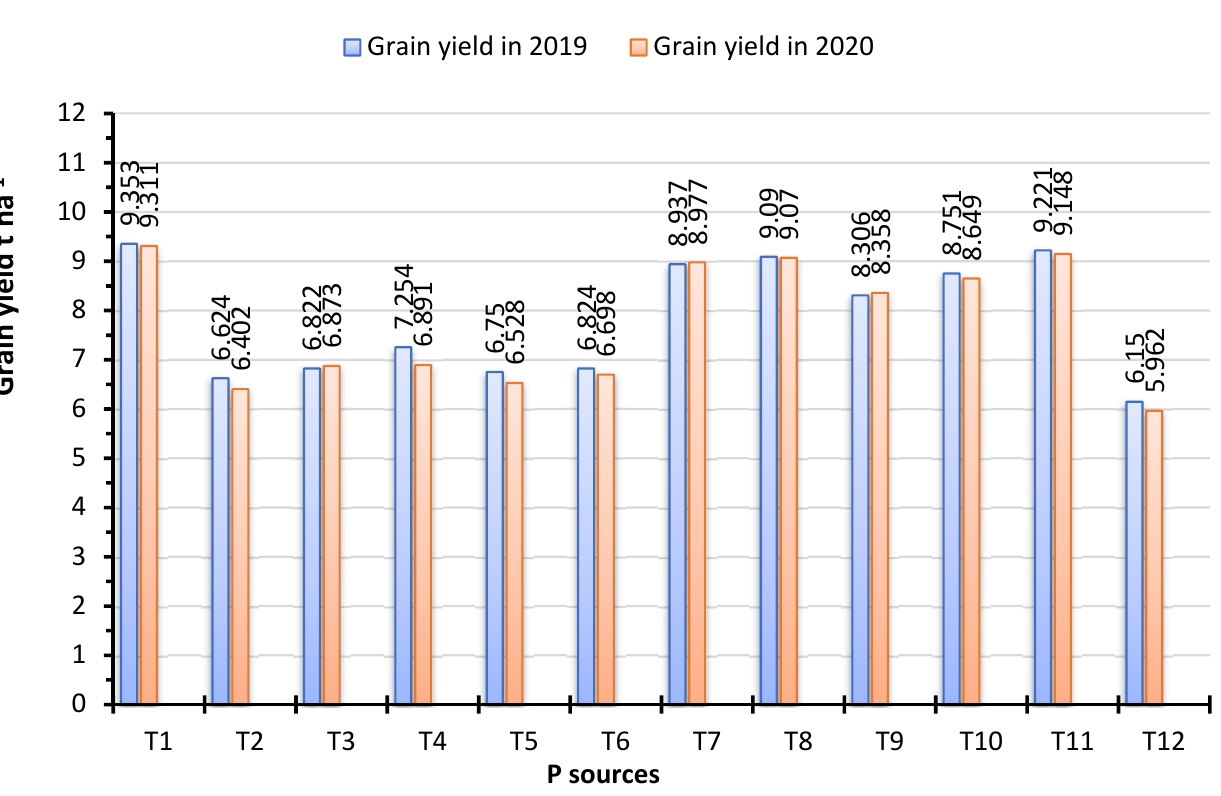
Figure 5. Grain yield of Sakha 106 rice cultivar was affected by arbuscular mycorrhizal fungi, phosphate-solubilizing bacteria and selected chemical phosphorus fertilizers in the 2019 and 2020 seasons. SSP, single super phosphate (15% P 2 O 5 ); PSBs, phosphate-solubilizing bacteria; AMFs, arbuscular mycorrhizal fungi; PNPs, phosphorus nanoparticles; PA, phosphoric acid. T1, basal application of 100% single super phosphate (SSP) (P1); T2, basal application of 75% SSP (P2); T3, P2 + top-dressing with phosphate-solubilizing bacteria (PSBs); T4, P2 + top-dressing with arbuscular mycorrhizal fungi (AMFs); T5, P2 + foliar spraying of phosphorus nanoparticles (PNPs); T6, P2 + foliar spraying of phosphoric acid (PA); T7, P2 + top-dressing with PSBs + AMFs; T8, P2 + foliar spraying of (PSBs + PNPs); T9, P2 + foliar spraying of (PSBs + PA); T10, P2 + foliar spraying of (PNPs + PA); T11, P2 + foliar spraying of (PSBs + PNPs + PA); T12, zero-phosphorus fertilizer (Control)